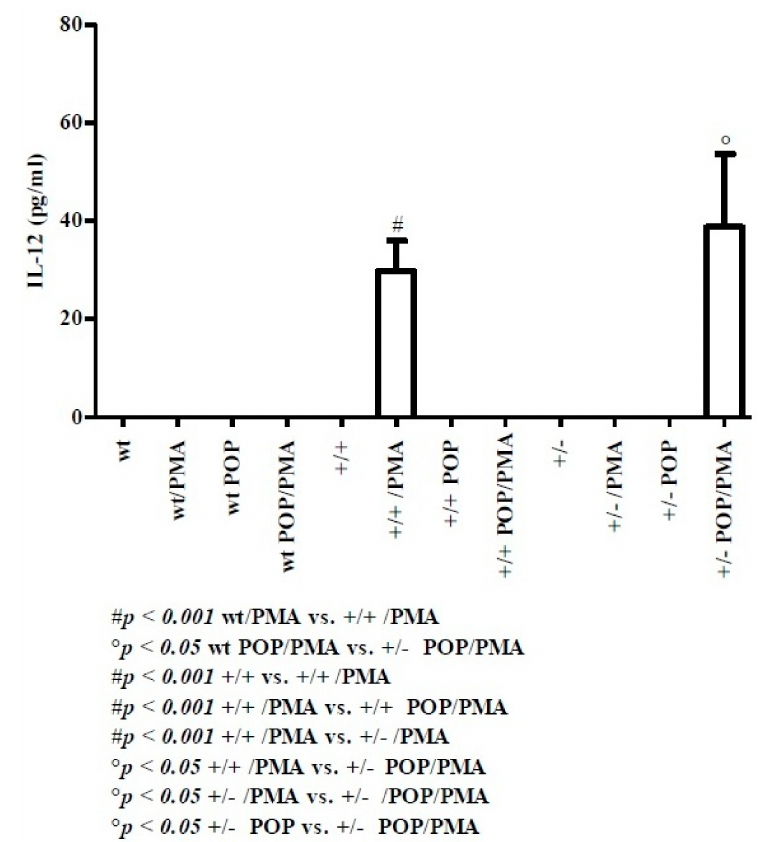
Figure 1. Levels of IL-12 in splenic supernatants from cell cultures of postnatal day 8